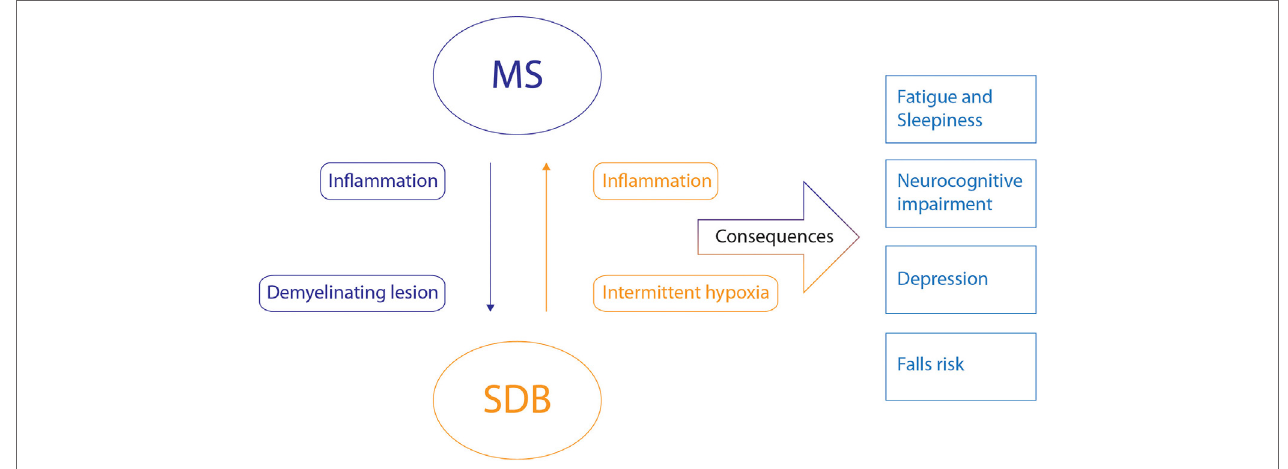
FigURe 4 | Potential bidirectional relationships between multiple sclerosis (MS) and sleep-disordered breathing (SDB) and their shared consequences. The potential bidirectional pathophysiological relationship between MS and SDB is indicated by the arrows with the corresponding mechanisms. Inflammatory state and demyelinating lesions of MS may induce or influence SDB. Intermitted hypoxia and inflammation caused by SDB may also influence MS. The consequences that these disorders share are indicated on the right. The combination of these disorders will likely negatively influence these